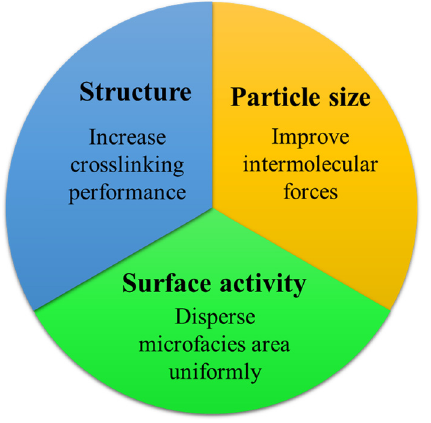
Figure 6: The reinforcement mechanism of rubber materials and